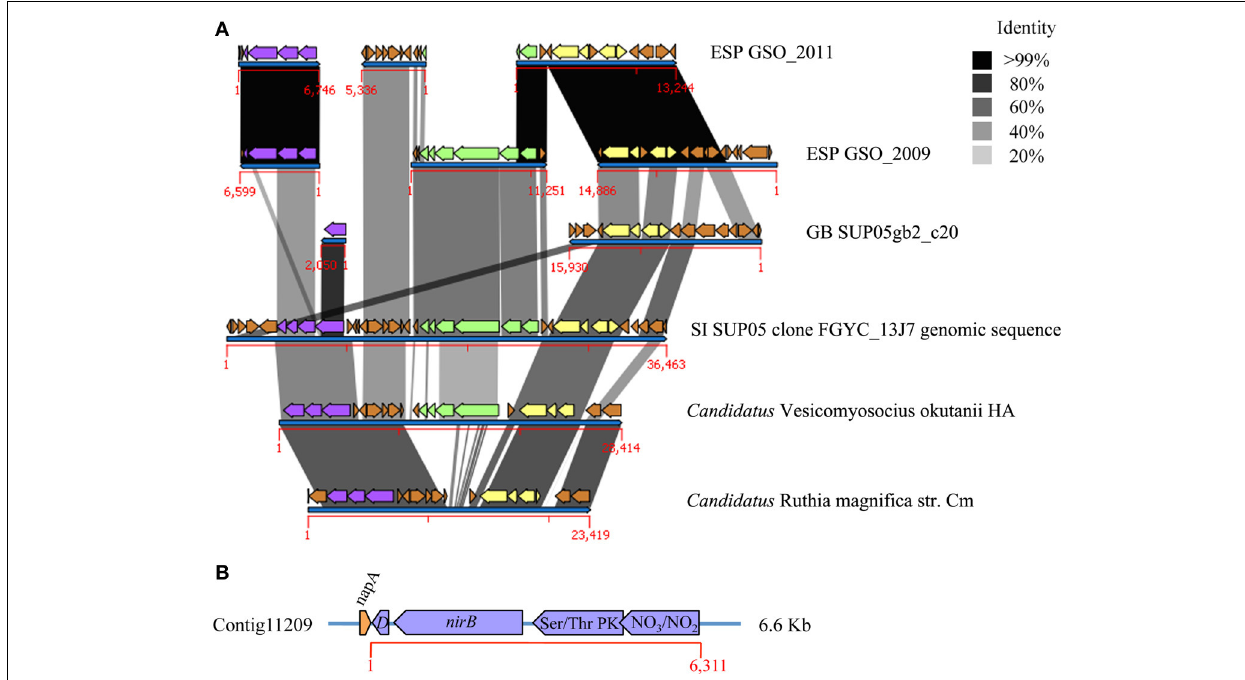
FIGURE 2 | Genetic context of the nirBD genes, nar, and RuBisCO operons. (A) Comparison of de novo contigs constructed with metagenomic sequences from 2009 and 2011 sampling ( ≥ 99% of identity is represented by the black color of the synteny comparisons). The nirBD operon is shown in purple and is located physically near the nitrate reductase ( nar , light green) and RuBisCO operons (yellow) in the Saanich Inlet SUP05 clone FGYC_13J7, and in the genome of Candidatus Vesicomyosocius okutanii. In the Candidatus Ruthia magnifica genome the nar operon is absent, but the region maintains some similarity to the narG gene. In the case of the